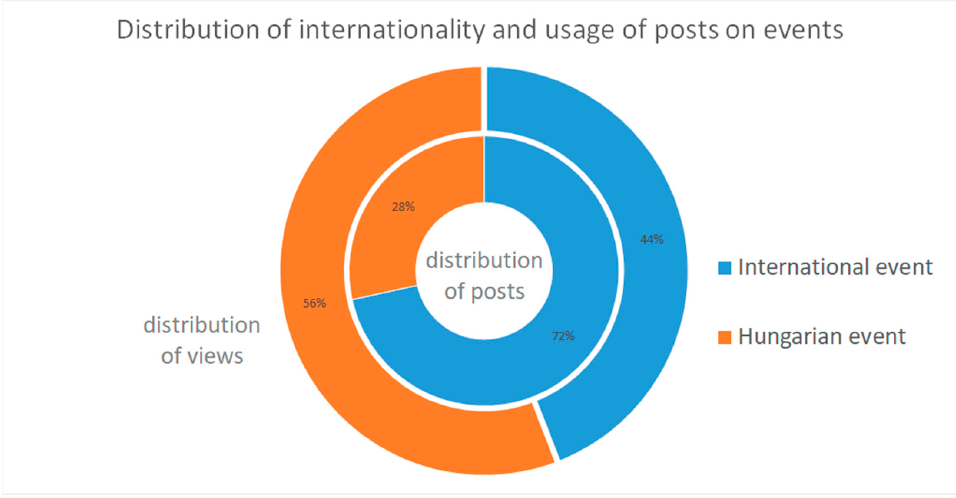
Figure 4. Distribution of internationality and usage of posts on events.